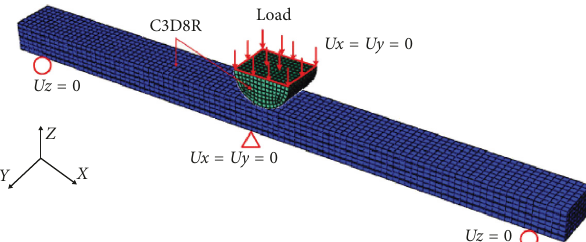
Figure 7: Finite element model for three-point bending.